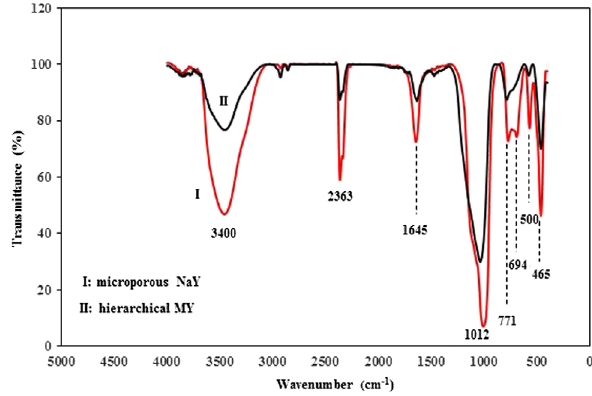
Figure 1: FT-IR spectra of (I) microporous NaY and (II) hierarchical MY.